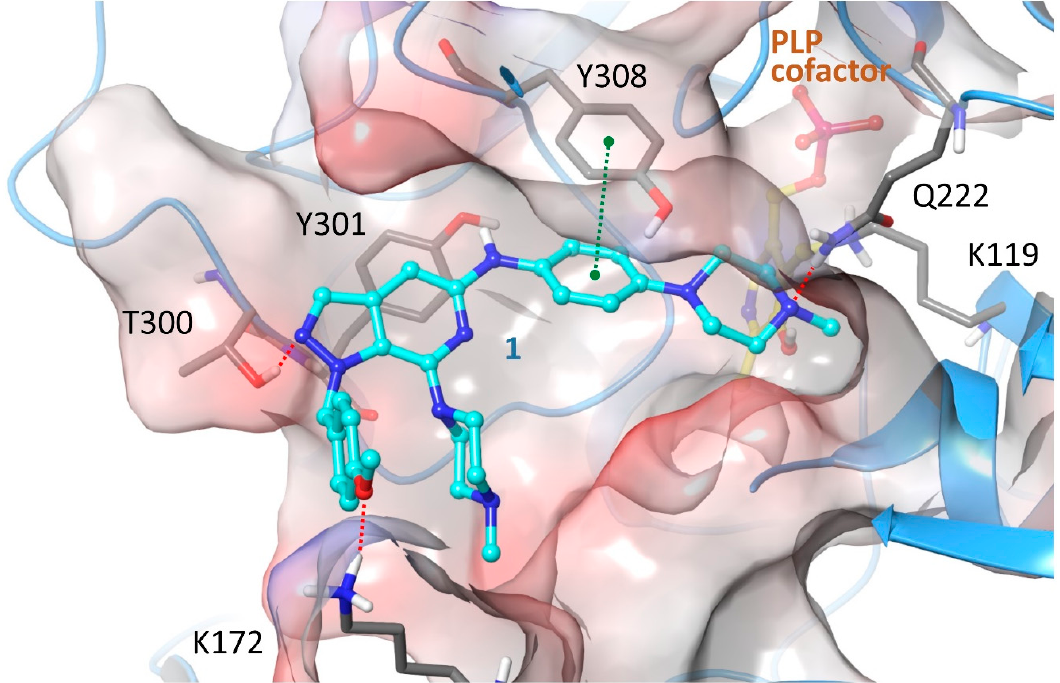
Figure 4. The dominant binding geometry of 1 inside the CBS active site as determined by the induced-fit algorithm for docking calculations. The inhibitor is anchored to the enzyme by a number of hydrogen bonds depicted as red dashed lines, whereas a strong stacking interaction between the phenylamino ring of 1 and Tyr308 (shown as green dashed line) further stabilizes the complex. The two piperazine rings of the inhibitor are deprotonated, whereas piperazine of R2 is positioned in close proximity to the catalytic Lys119, covalently attached in this structure to the cofactor pyridoxal aldehyde as a Schiff base. The protein is depicted as a blue ribbon and molecular surface colored according to the electrostatic potential (red: negative; blue: positive). The ligand and protein interaction geometry demonstrates high complementarity and an excellent occupancy of the pocket by the inhibitor.